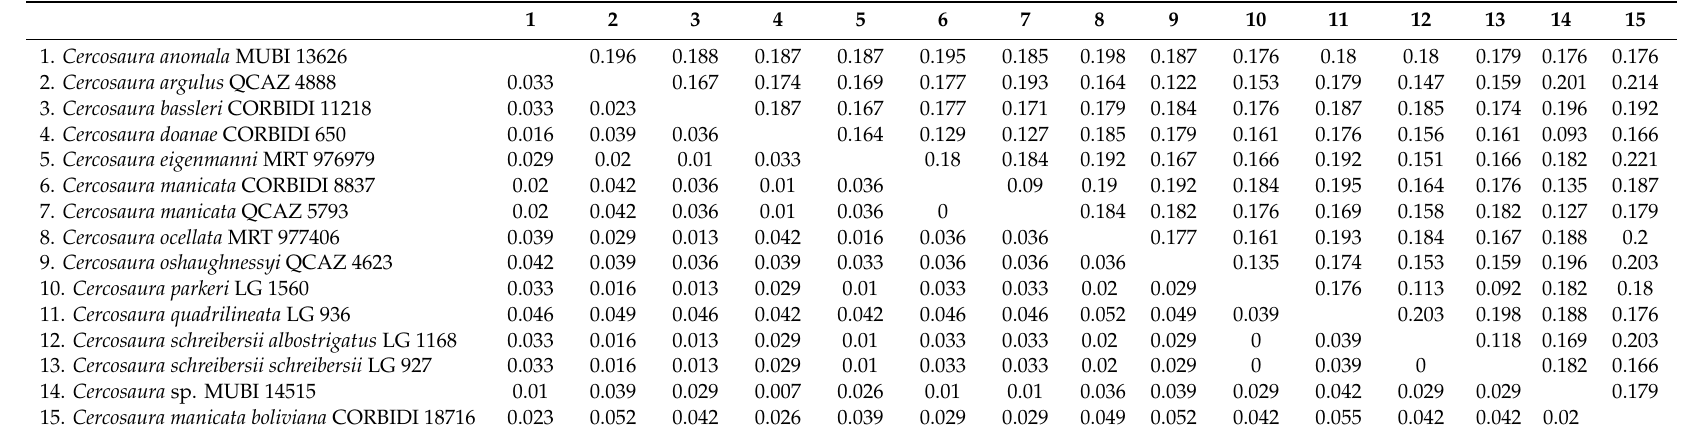
Table 4. Uncorrected p-distances for ND4 (top) and c-mos (bottom) genes between Cercosaura anomala , Cercosaura sp., and “ C. manicata boliviana” and other cercosaurine